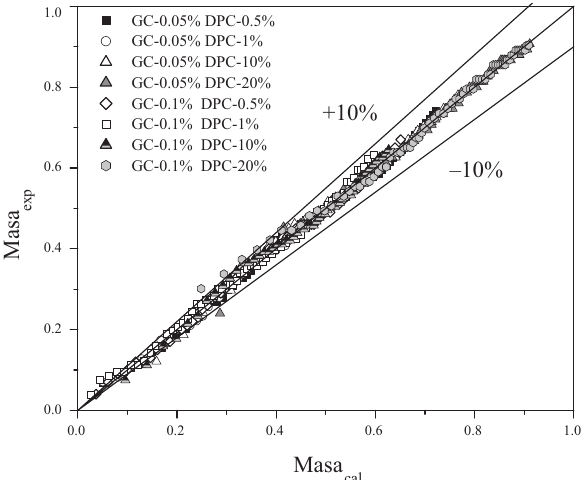
Fig. 10. Correlation between experimental values (massexp) and calculated (masscal) by means of the Hill equation for the second phase of the imbibition process